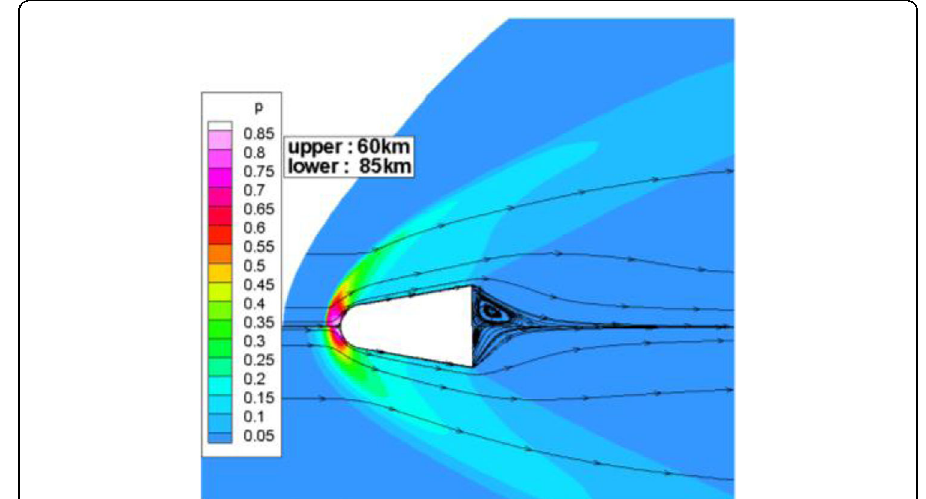
Fig. 23 Pressure contour and streamlines